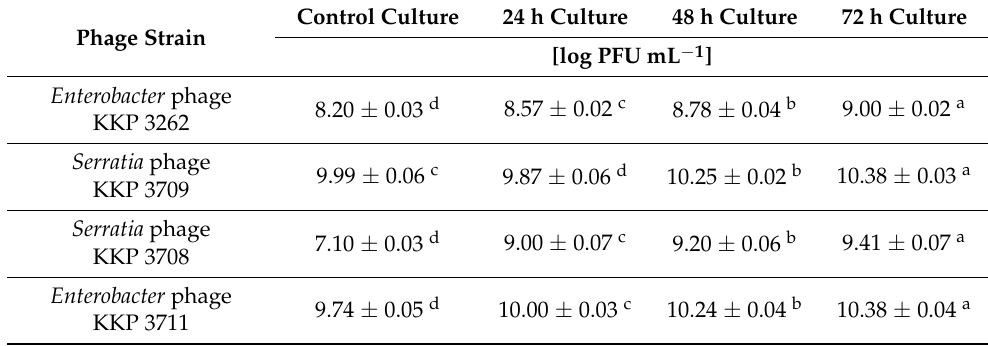
Table 2. Bacteriophage concentration in phage lysates after consecutive hours of culture. Control Culture 24 h Culture 48 h Phage Strain